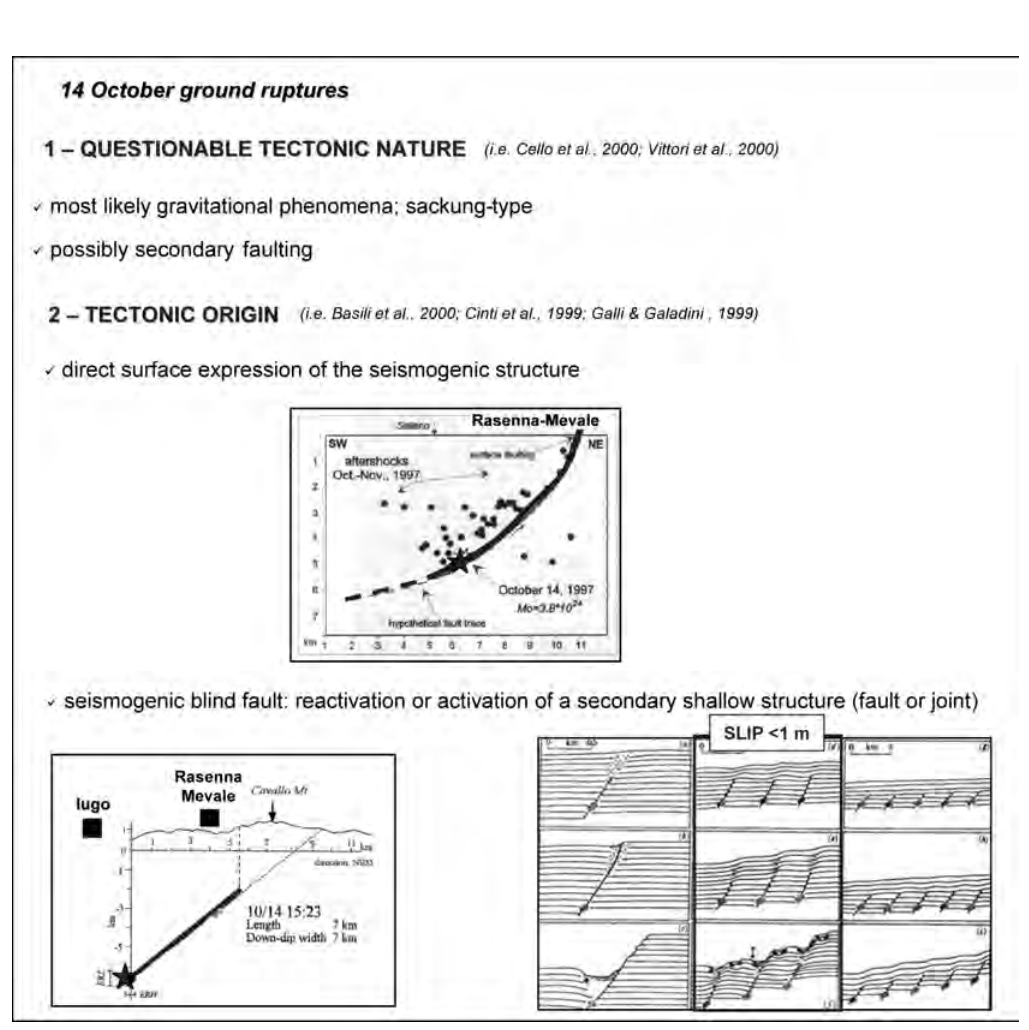
Fig. 11. Different interpretations of the ground ruptures and of the fault plane geometry associated with the 14 October event. Sketch corresponding to the surface faulting interpretation shows a hypothetical section of the earthquake plane reaching the surface by Galli and Galadini (1999). Sketches corresponding to the blind fault hy- pothesis: to the lower left is shown the relative location of ground ruptures (black square) and fault plane (assum- ing constant dip) by Cinti et al . (1999); to the lower right are the hypotheses of alternative surface expressions that relate to slip at depth, by Vita-Finzi and King (1985). The red box may reproduce the Umbria-Marche case: the surface is characterized by secondary structures including folding, but the main faults do not reach the